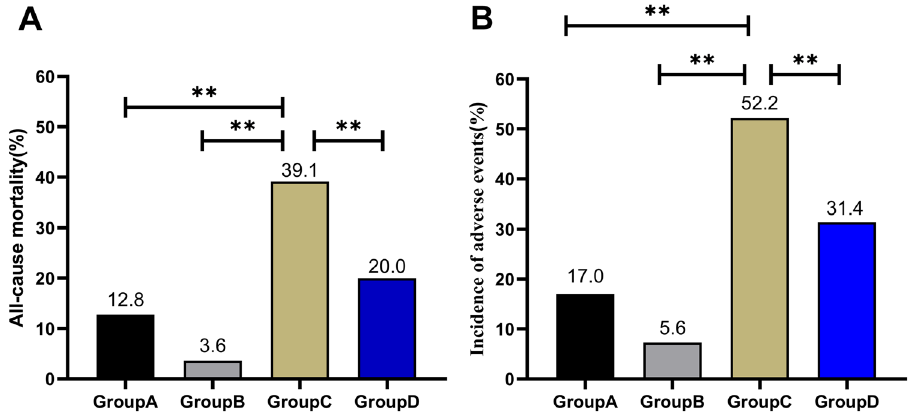
Figure 2. Comparison of observation endpoints according to CO 2 CP combined with serum sodium levels. ( A ) All-cause death; ( B ) adverse events.